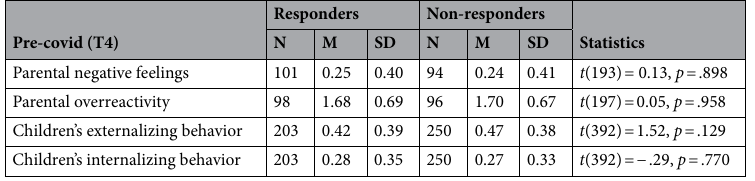
Table 5. Mean and standard deviations of variables of interest between responders (current sample) and non- responders within the larger L-CID study at time point 4.